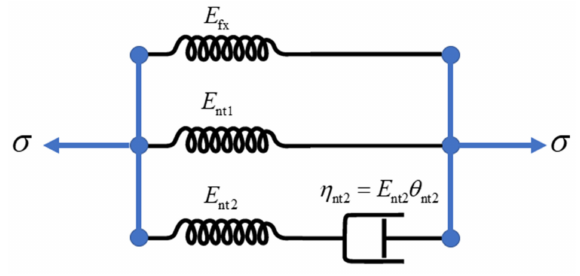
Figure 9. Concept diagram of optimized